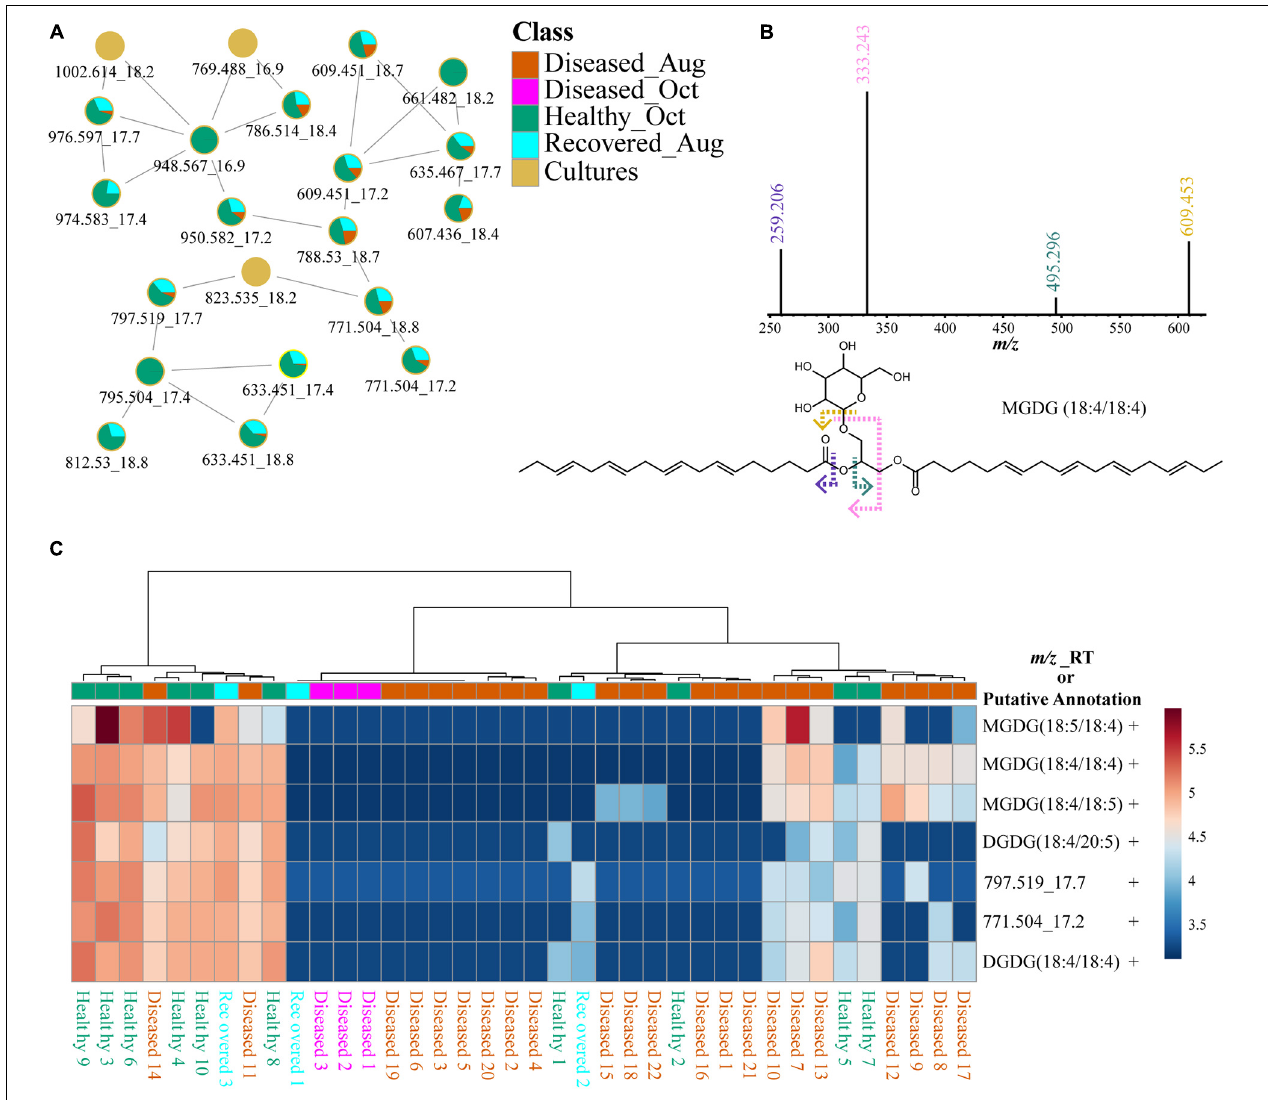
FIGURE 9 | Description of putatively annotated glycolipids using molecular networking, fragmentation spectra, and distribution via heat maps. (A) Shows the FBMN of glycolipids. (B) Shows specific fragments with m/z 333.243 and 259.206 observed in the MS 2 spectra of glycolipids support the annotation of acyl tail as 18:4. (C) Heat map of seven glycolipids across healthy, diseased, and recovered coral samples grouped via analysis of variance from LC-MS data generated using MetaboAnalyst. The scale bar represents log-transformed intensity of these lipids. This figure illustrates a subset of glycolipids. A comprehensive list of all glycolipids and the heat map for these features is provided in Supplementary Table 3 and Supplementary Figure 6 . The m/z _RT value or putative annotations are included for each feature. The ± indicates presence or absence of this feature in the LC-MS data acquired on cultured